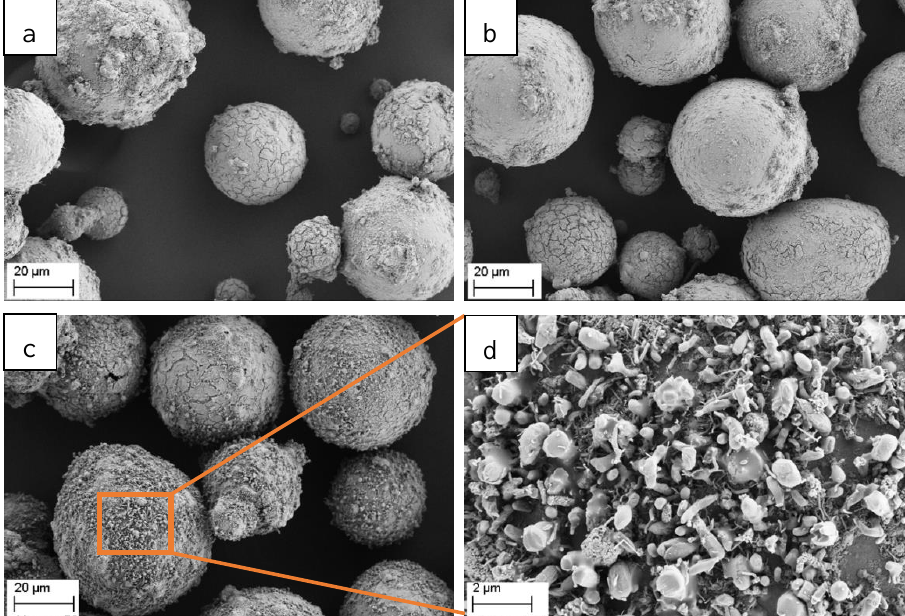
Figure 12. SEM images of the post-treated (furnace) SMGS Type S (Experiment 2 A). No significant change in surface morphology at a temperature of 400 °C ( a ) and 500 °C ( b ) is apparent. For a temperature of 750 °C ( c,d ) a more inhomogeneous surface occurs due to the recrystallization of aluminum.